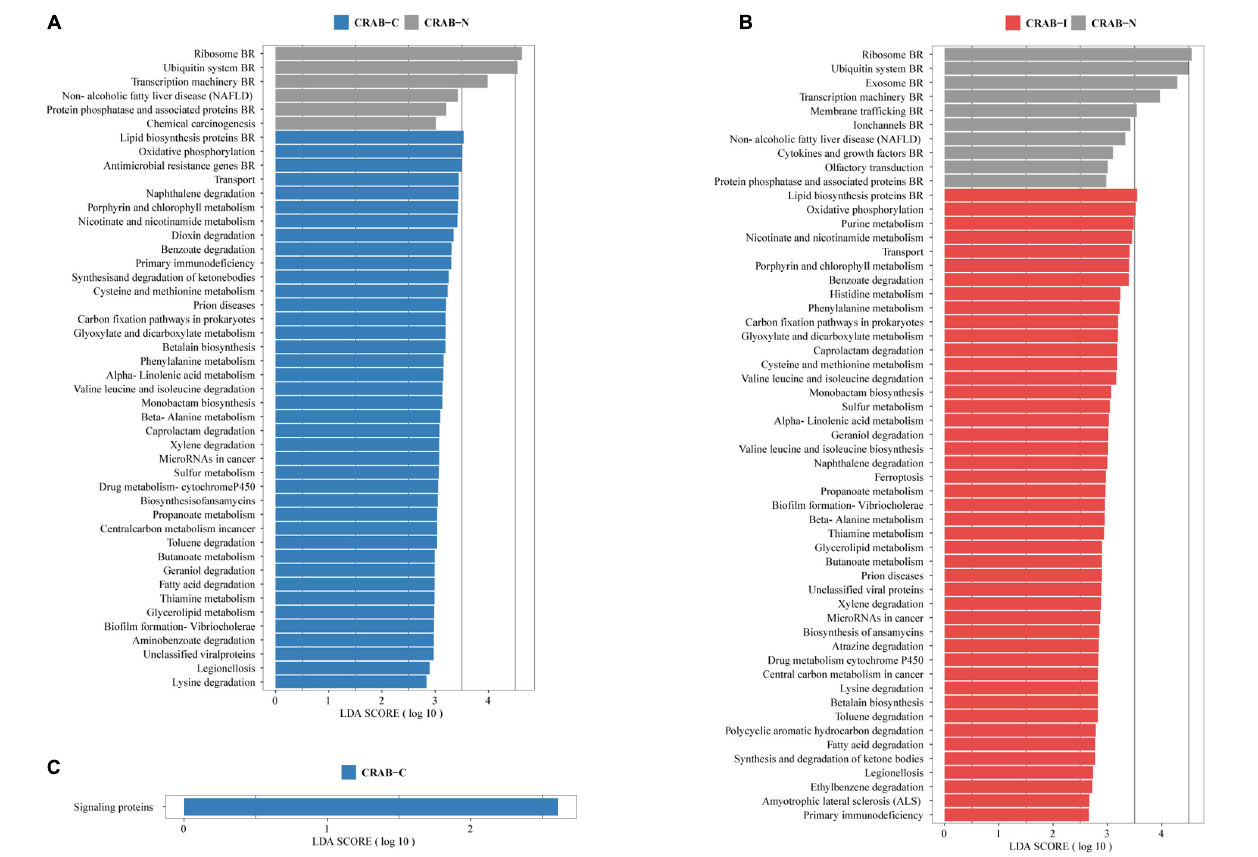
FIGURE 5 | Functionally distinct and LEfSe analysis based on KEGG pathway. (A) Linear discriminant analysis (LDA) scores indicate significant differences in the microbiota between the CRAB-C patients (blue) and CRAB-N controls (gray); (B) LDA scores indicate significant differences in the microbiota between the CRAB-I patients (red) and CRAB-N controls (gray); (C) LDA scores indicate significant differences in the microbiota between the CRAB-C patients (blue) and CRAB-I patients (red). LDA scores > 2.5. CRAB, carbapenem-resistant Acinetobacter baumannii ; LRT, lower respiratory tract; VAP, ventilator associated pneumonia; CRAB-N, LRT microbiota of patients with neither VAP nor CRAB LRT colonization; CRAB-C, LRT microbiota of patients with CRAB colonization but without VAP; CRAB-I, LRT microbiota of patients who developed CRAB